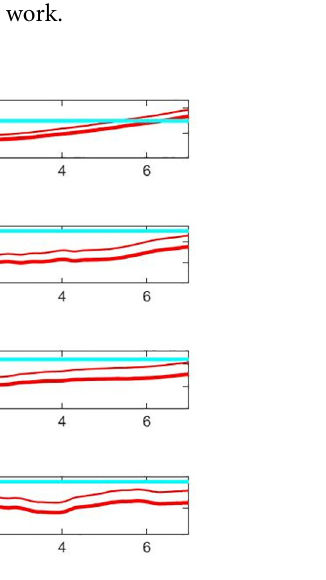
Fig 10. Prediction of unit load in Scenario